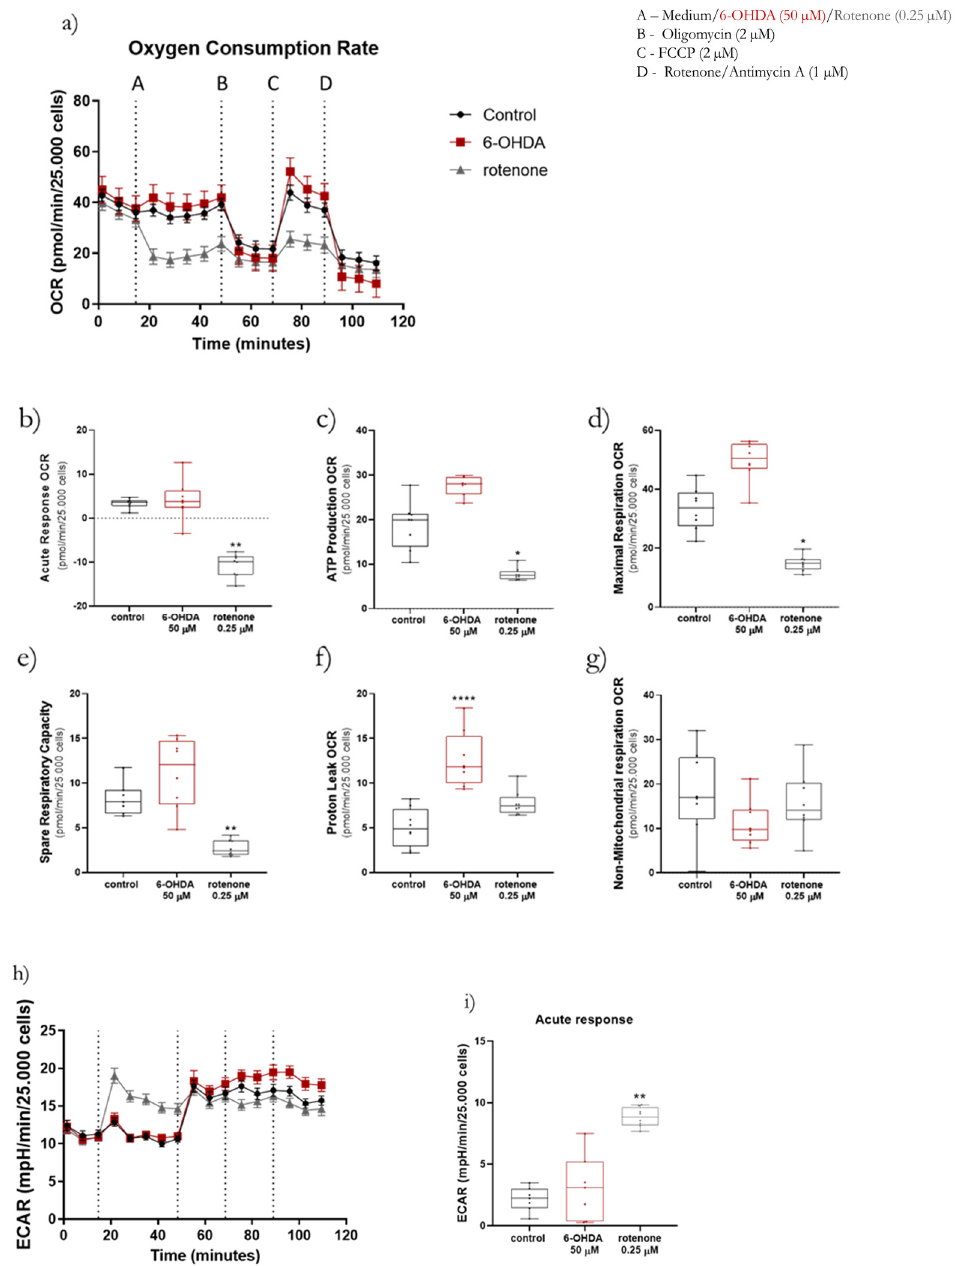
Figure 5. Acute treatments with 50 µ M 6-OHDA and with 0.25 µ M rotenone differently affected mitochondria bioenergetics. Differentiated SH-SY5Y were acutely treated with 50 µ M 6-OHDA or with 0.25 µ M rotenone just prior to the conventional Seahorse XF Cell Mito Stress Test. OCR was assessed over time with the addition of 6-OHDA or rotenone (A), Oligomycin (B), FCCP (C), and rotenone/antimycin A (D) ( a ). Mitochondrial bioenergetic parameters acute response ( b ), ATP production ( c ), maximal respiration ( d ), spare respiratory capacity ( e ), proton-leak ( f ) and non-mitochondrial respiration ( g ) -linked OCR, as well as the ECAR profile ( h , i ) were distinctly affected by 6-OHDA and rotenone. Data are represented in boxplots in which each dot represents the mean of an independent cell population ( n = 8). Kruskal–Wallis test (one-way ANOVA on ranks) pairwise (control vs. 6-OHDA or control vs rotenone) was used to assess statistical significance, (*) p < 0.05, (**) p < 0.01, (****) p < 0.0001.